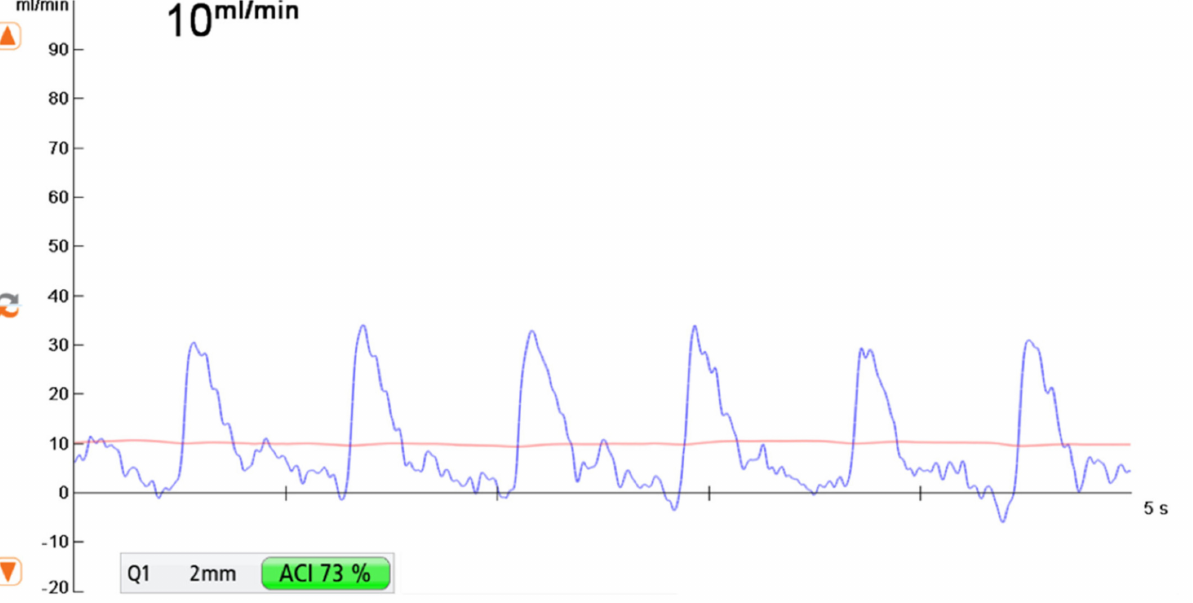
Figure 1. Transit-Time Flow Volume Measurement (TTFM) showing a flow volume of 10 mL/min with an Acoustic Coupling Index (ACI) of 73% using a 2 mm